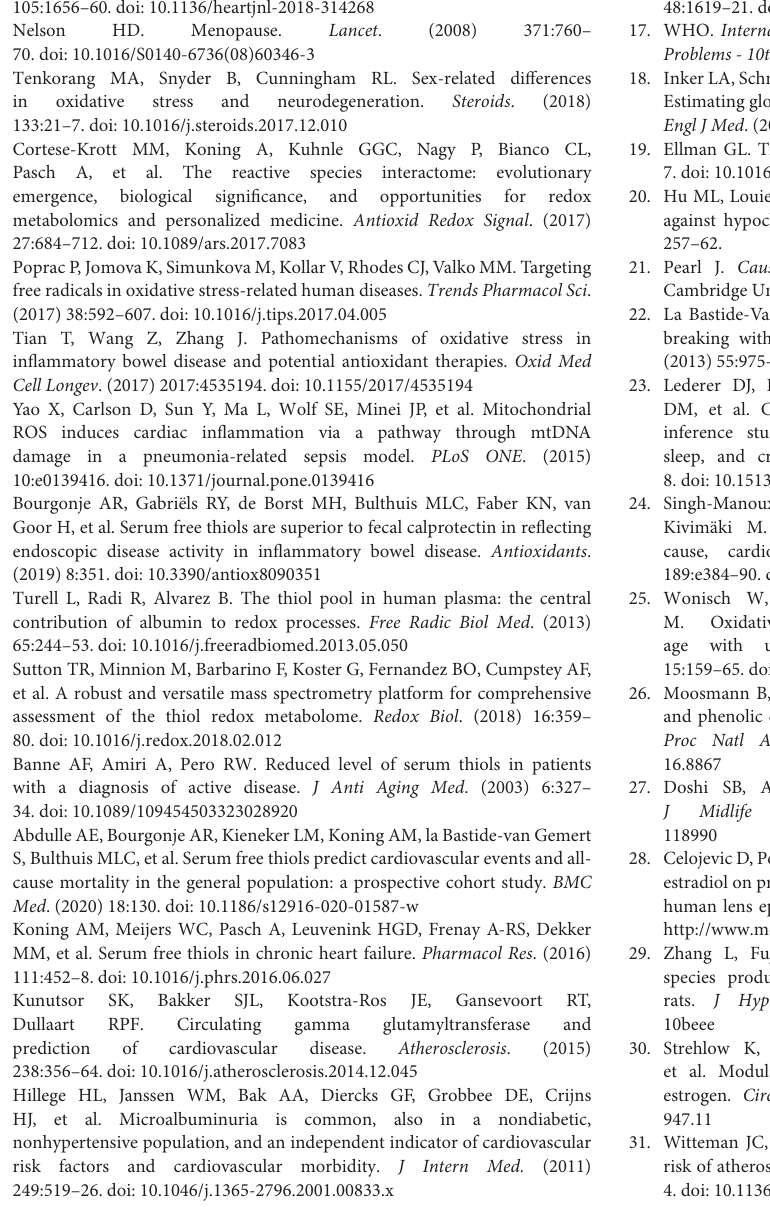
Supplementary Figure 1 | Serum free thiols are significantly reduced in postmenopausal women ( ∗∗∗ P < 0.001).